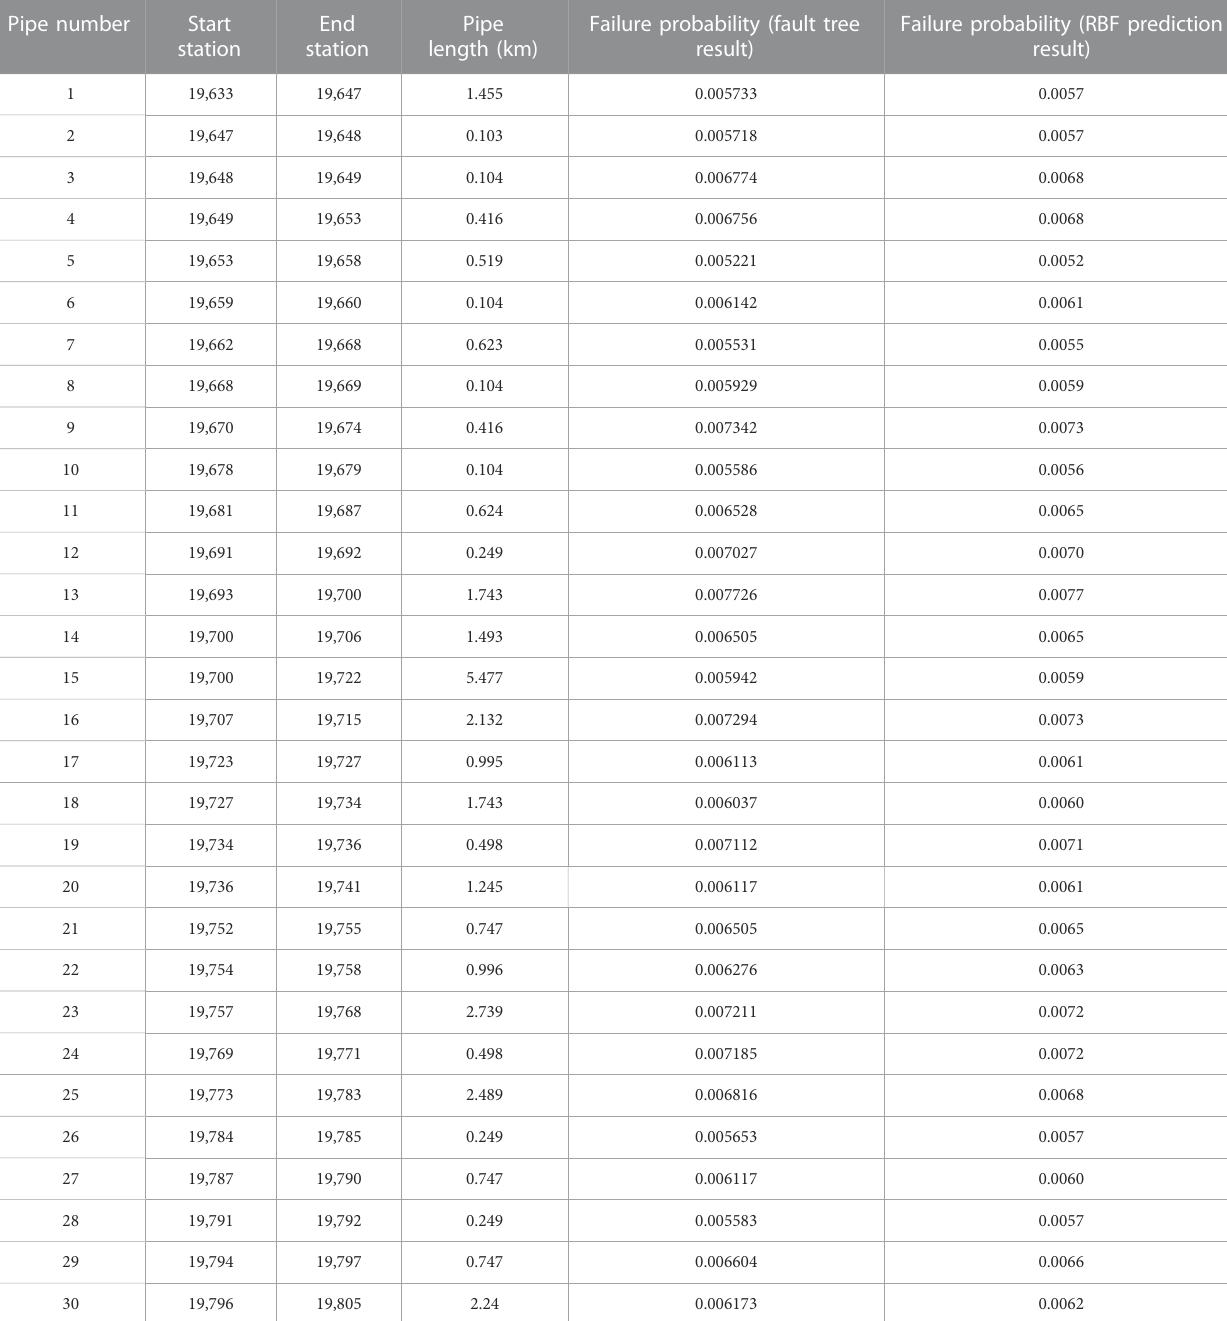
TABLE 3 Corrosion failure probability of buried gathering and transmission